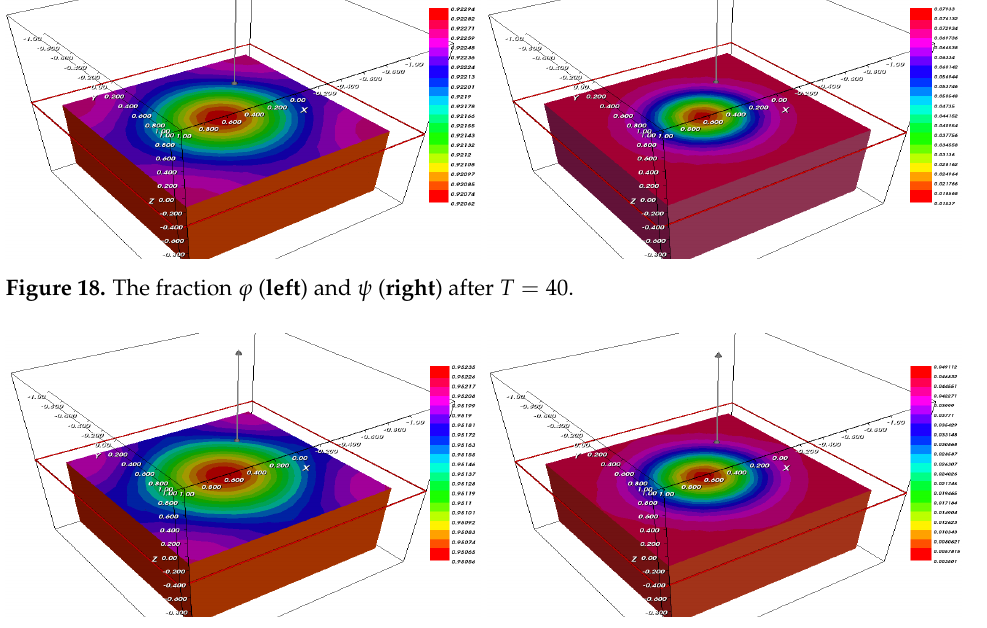
Figure 19. The fraction ϕ ( left ) and ψ ( right ) after T = 50.